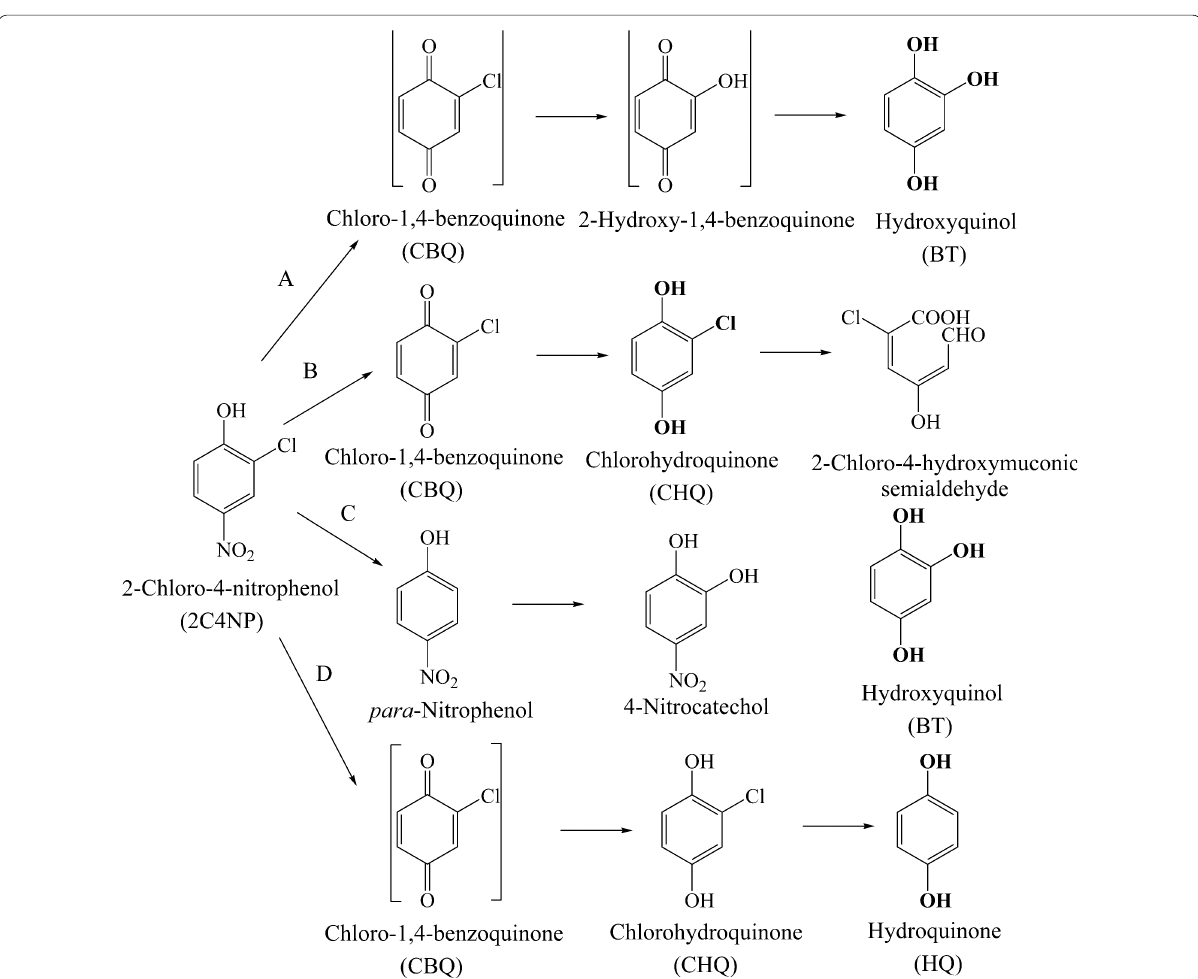
Fig. 6 Proposed pathways of 2C4NP degradation by 2C4NP utilizers. (A) Cupriavidus sp. strain CNP-8 (this pathway was also seen with Rhodococ- cus imtechensis strain RKJ300, reported previously); (B) Burkholderia sp. strain SJ98 [reported by Min et al. (2014)]; (C) Burkholderia sp. strain SJ98 [reported by Pandey et al. (2011)]; (D) Burkholderia sp. strain RKJ800. The unidentified intermediates are in brackets. The structures of ring cleavage compounds are indicated in